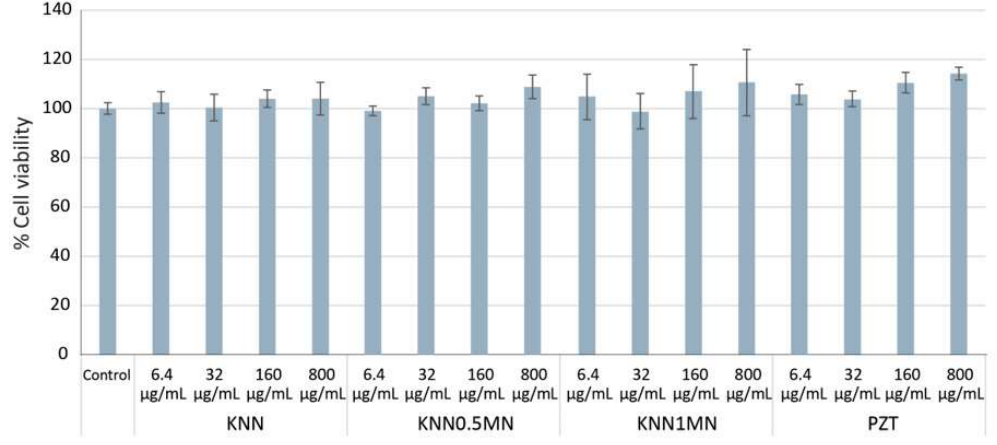
Figure 8. A549 cells viability after exposure to different concentrations of KNN, KNN-0.5MN, KNN-1MN, and PZT. “Control” corresponds to non-exposed cells.